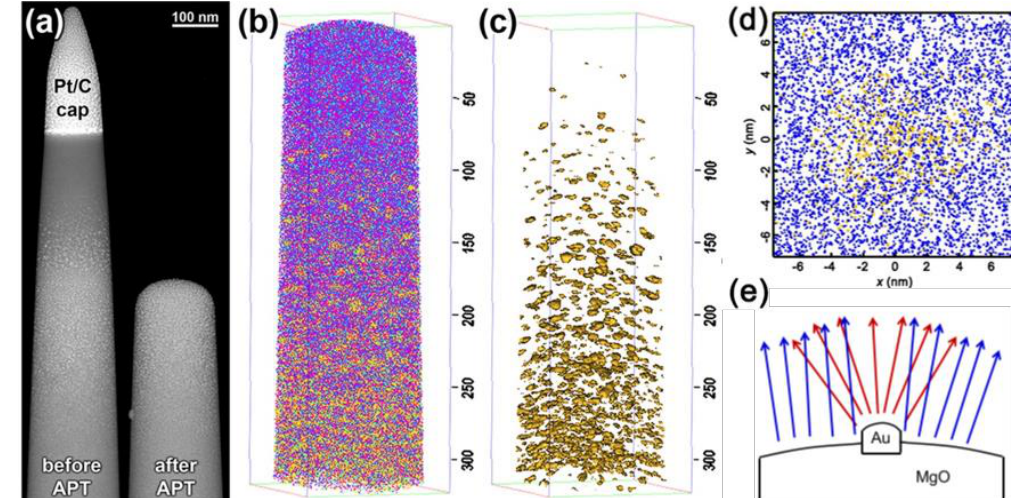
Figure 10. Correlative APT-STEM study of Au / MgO system as supported catalyst. ( a ) HAADF-STEM image of the specimen before and after APT experiments to correlate the morphology of Au nanoparticles; ( b ) 3D atom map of the specimen analyzed by APT (O is represented as cyan, Mg as magenta and Au as yellow); ( c ) 3D maps representing only Au-rich regions (by applying the isosurface method); ( d ) individual cluster highlighting the presence of a diffuse Au/MgO interface and the presence of MgO within the Au nanoparticle; and ( e ) schematic representation of the Au protrusion leading to trajectory overlaps and local magnification. Panels (a – d): reprinted with permission from [150]. Copyright (2014) American Chemical Society. Panel (e): reprinted with permission from [149150]. Copyright (2012) Cambridge University Press.